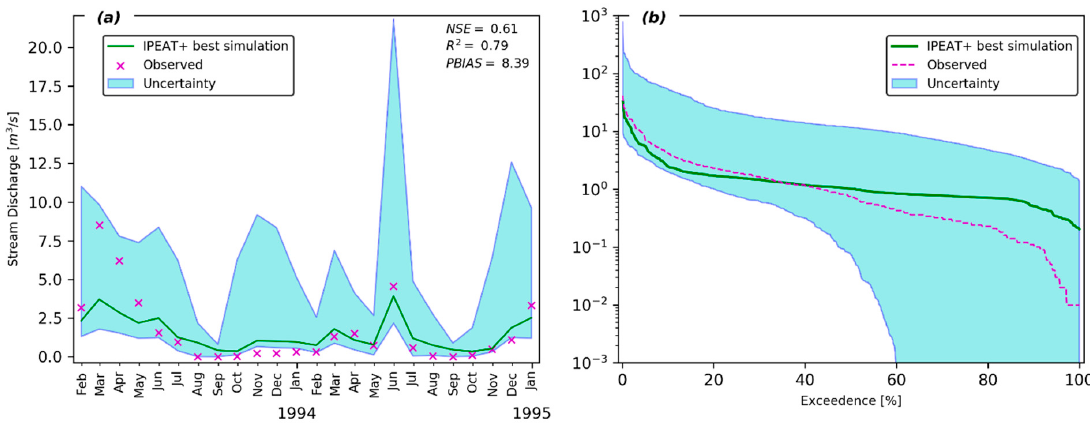
Figure 10. Hydrologic processes of the calibrated SWAT+ model by using IPEAT+: ( a ) Monthly average observed and best simulated time series of stream discharge; ( b ) daily observed and best simulated Flow Duration Curves, with simulated uncertainties resulting from the 1000 combinations of IPEAT+ ensemble parameter set for the Middle Bosque River watershed.